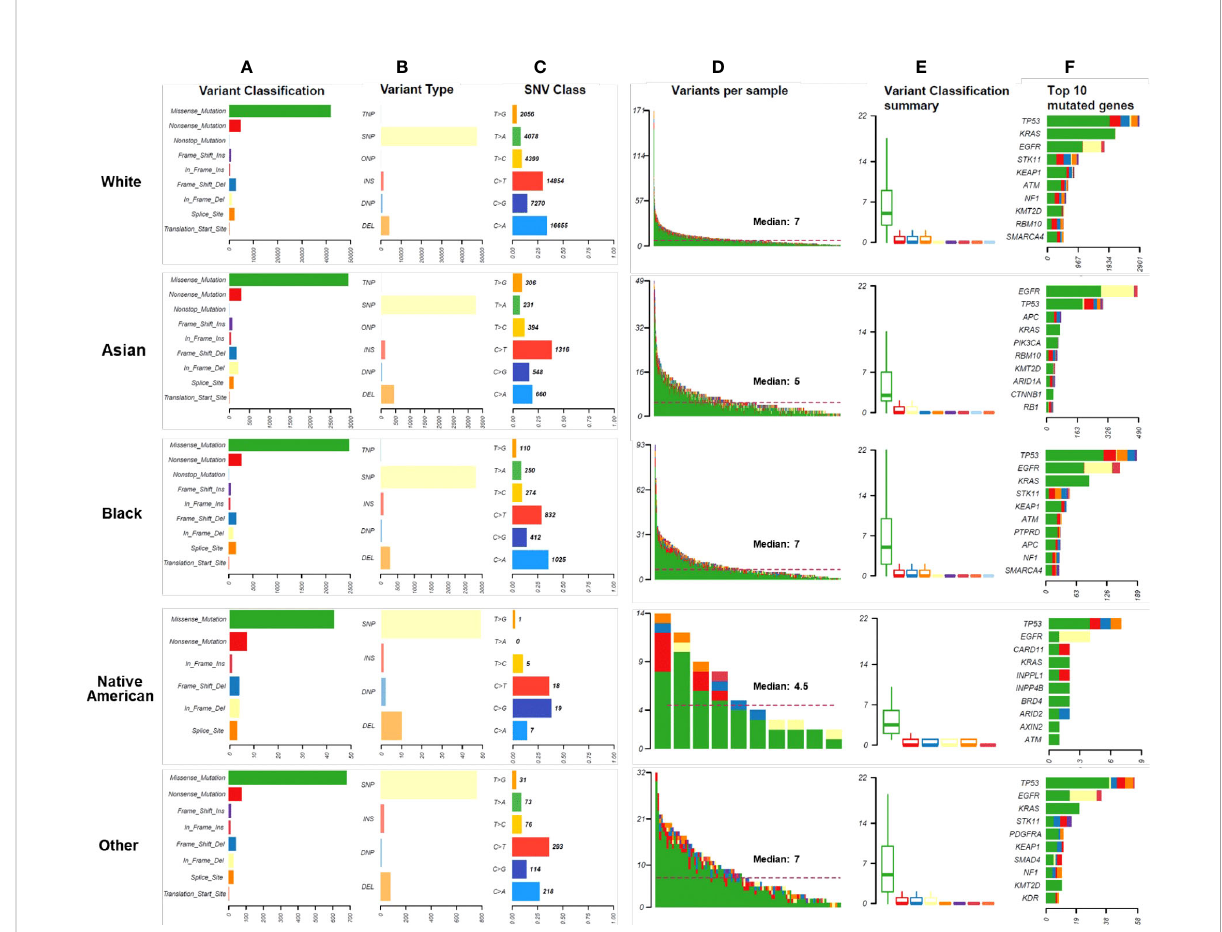
FIGURE 3 Mutational landscape in different races. (A) . The numbers and distributions of genomic variants in different races. Y-axis represented variant classi fi cation, including missense mutation, nonsense mutation, nonstop mutation, frameshift insertion, in-frame insertion, frameshift deletion, in-frame deletion, splice site, and translation start site. X-axis represented the number of variants. (B) . The numbers and distributions of variant types in different races. The speci fi c categories of somatic variants include single nucleotide polymorphism (SNP), double nucleotide polymorphism (DNP), triple nucleotide polymorphism (TNP), oligonucleotide polymorphism (ONP), insertion (INS), and deletion (DEL). Y-axis represented the variant type, and X-axis represented the number of variants. (C) . The distribution of SNV class in different races. To study mutations of base pairs, we identi fi ed six classes of base substitution: C>A, C>G, C>T, T>A, T>C, T>G. Y-axis represented the SNV class, and X- axis represented the percentage of each SNV class. The bold number represented the number of each SNV class. (D) . The distribution of variants per sample. The median number of genomic mutations per sample was represented. (E) . Variant classi fi cation summary in different races. (F) The top 10 mutated genes in races. Y-axis represented the names of the top 10 mutated genes, and X-axis represented the number of